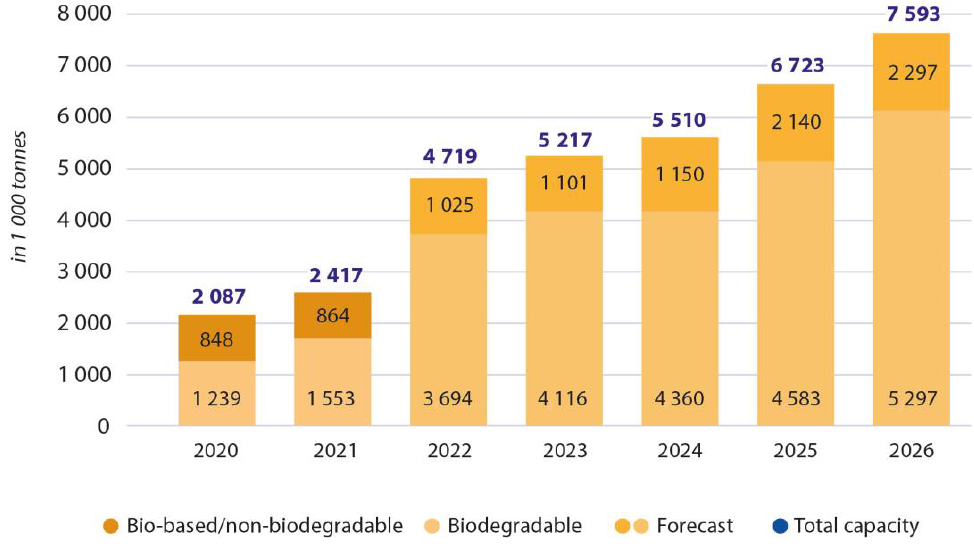
Figure 1. Global production capacities of bioplastics 2021 – 2026. Adapted from European Bioplastics, “ Bioplastics Market Development Update 2021” . https://docs.european-bioplastics.org/publications/market_data/Report_Bioplastics_Market_Data_2021_short_version.pdf (accessed on 29/12/2022) [6].